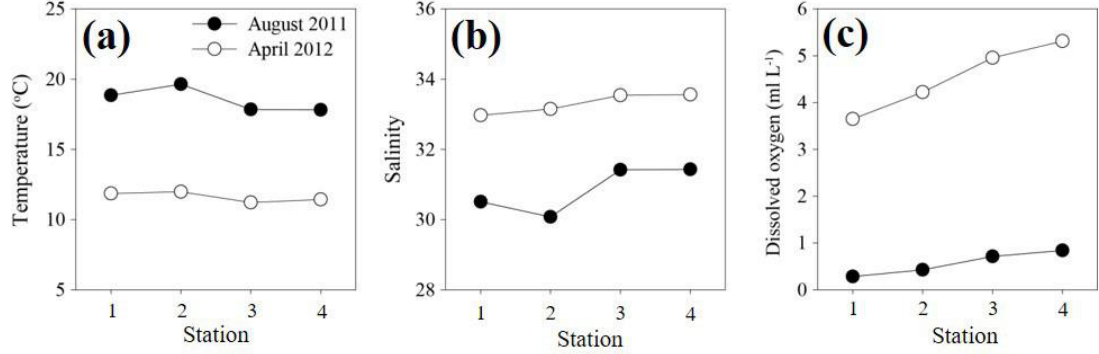
Figure 3. Vertical profiles of temperature, salinity, and dissolved oxygen in Masan Bay during August 2011 and April 2012. ( a ) Water temperature (°C), ( b ) salinity, and ( c ) dissolved oxygen (mL L − 1 ).